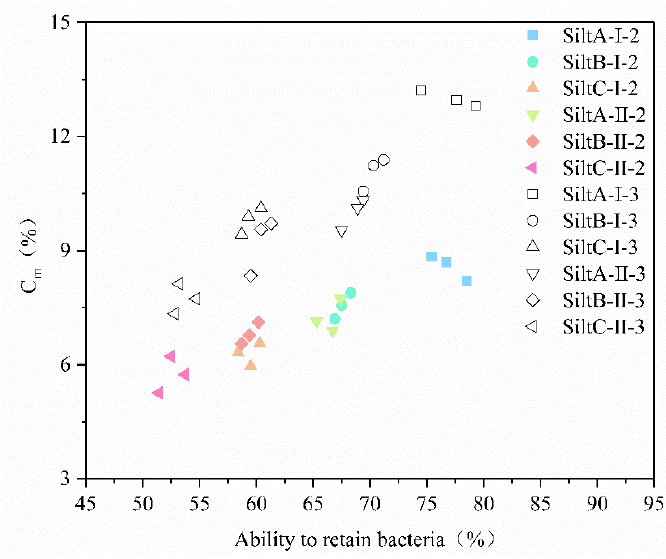
Figure 10. Relationship between retention bacteria capacity and CaCO 3 .